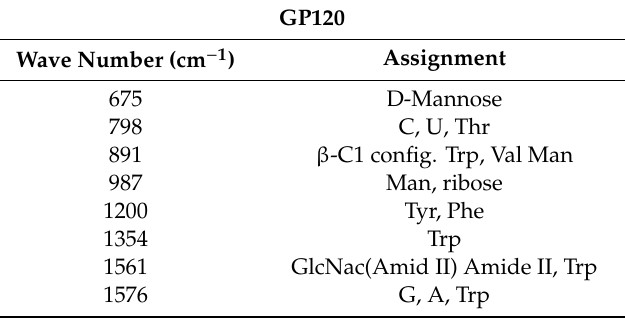
Table 2. Assignments of SERS peak of GP120.